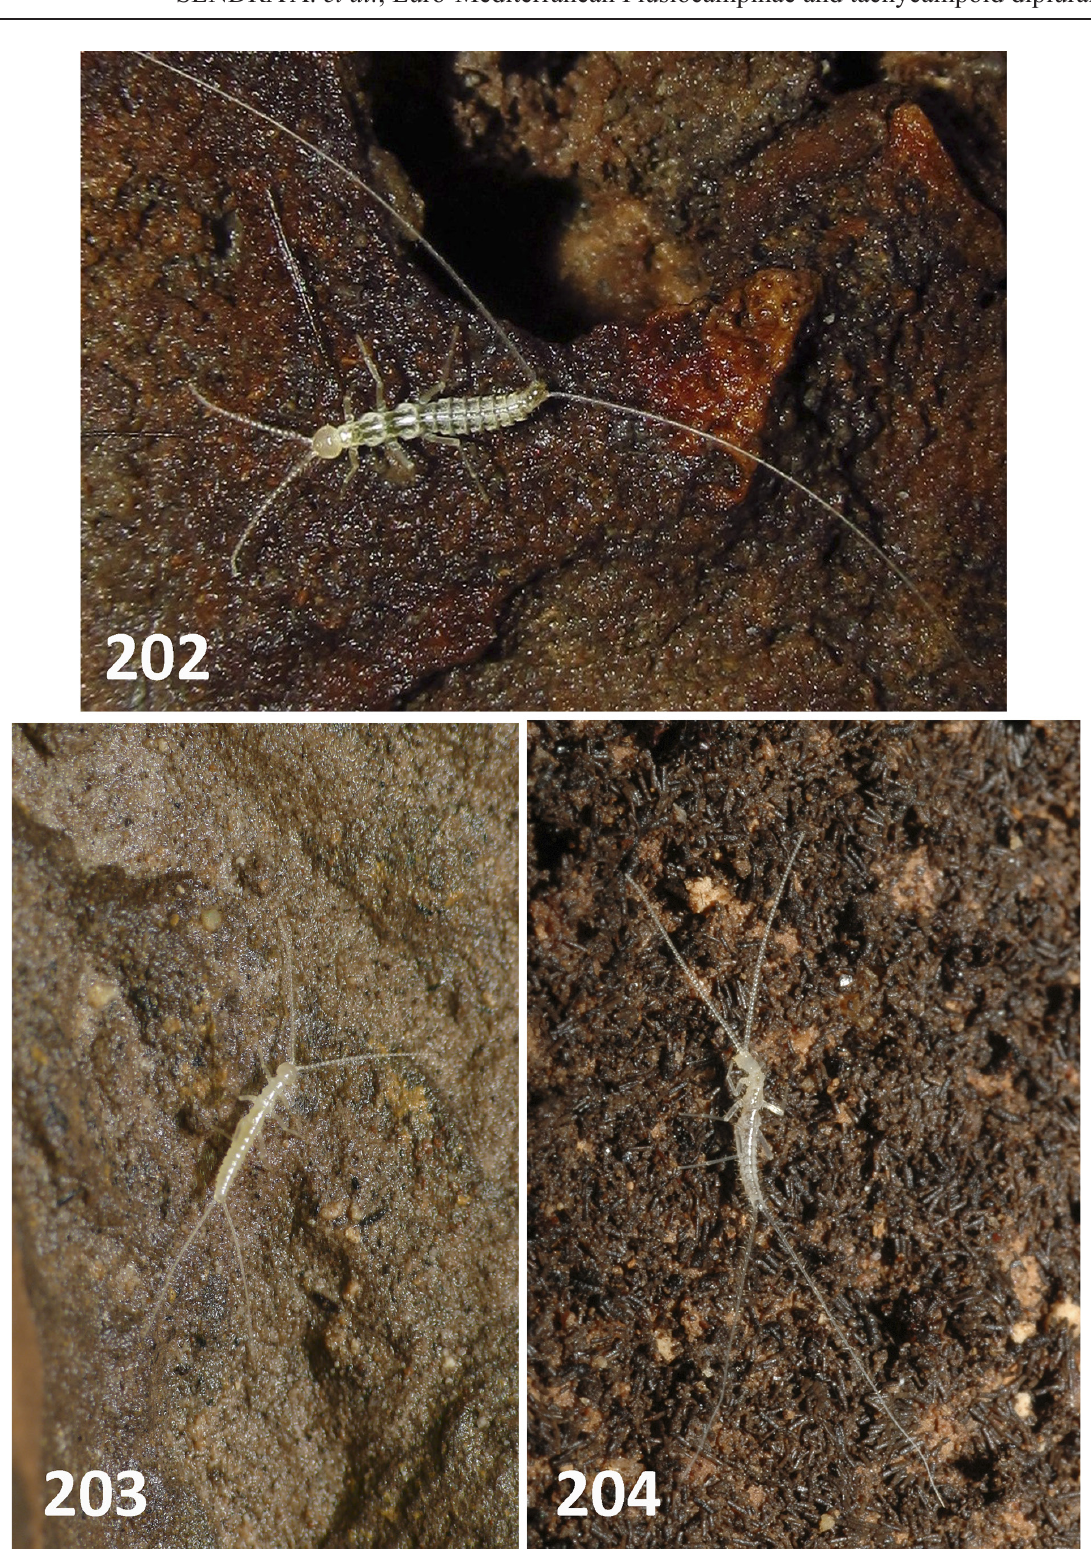
Figs 202–204. 202 . Plusiocampa ( Stygiocampa ) christiani Condé & Bareth, 1996, from Lazareva Cave, Serbia (photo: Dragan Antić). 203 . Plusiocampa ( Plusiocampa ) lagari Sendra & Condé, 1987, from Chorros Cave, Albacete, Spain (photo: Toni Pérez). 204 . Plusiocampa ( Plusiocampa ) hoffmanni Sendra & Paragamian sp. nov., from Splialio Sfentone Trypa Cave, Crete (photo: Kaloust